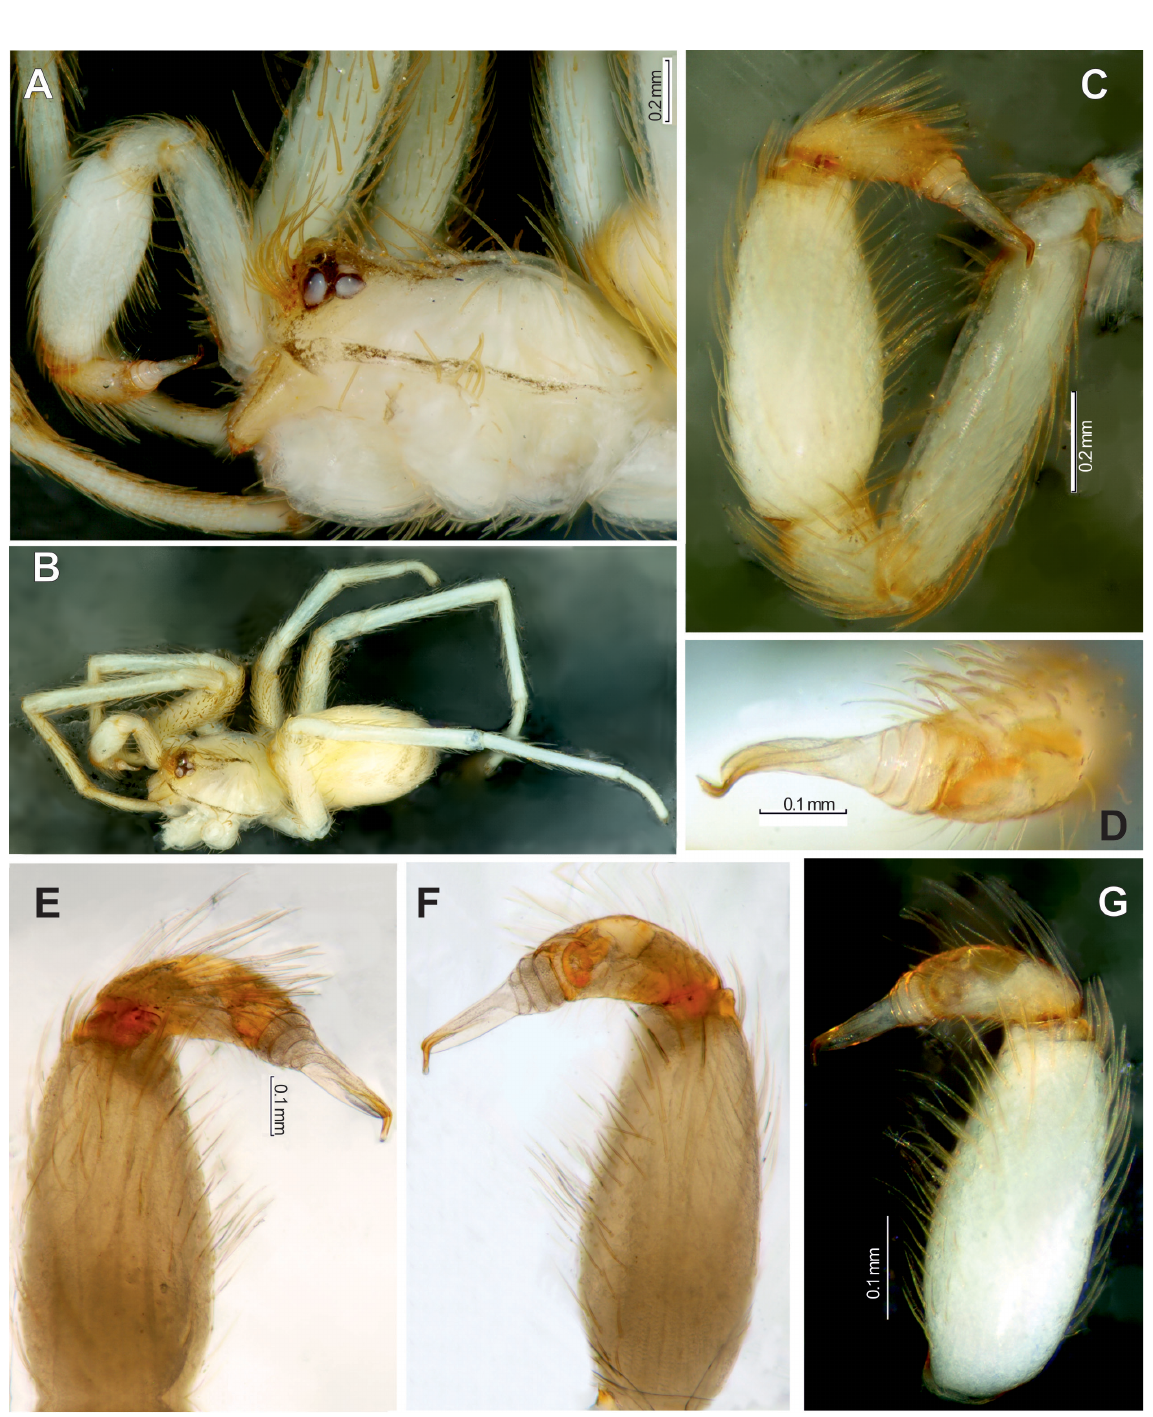
Fig. 32. Somatic characters and copulatory organs of Zaitunia wunderlichi sp. nov., paratype, ♂. — A . Prosoma, lateral. B . Habitus, dorso-lateral. C . Palp, prolateral. D . Cymbium and bulb, dorsal. E . terminal part of palp, prolateral. F – G . Same,